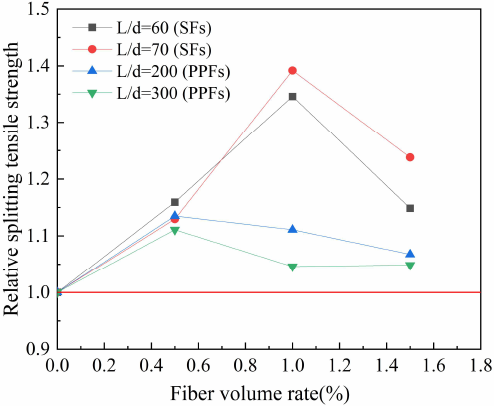
Figure 19. The effect of fiber aspect ratio on splitting tensile strength.